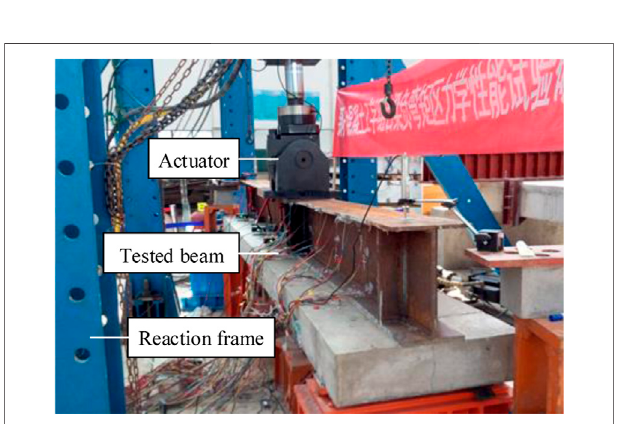
FIGURE 7 | Fatigue test